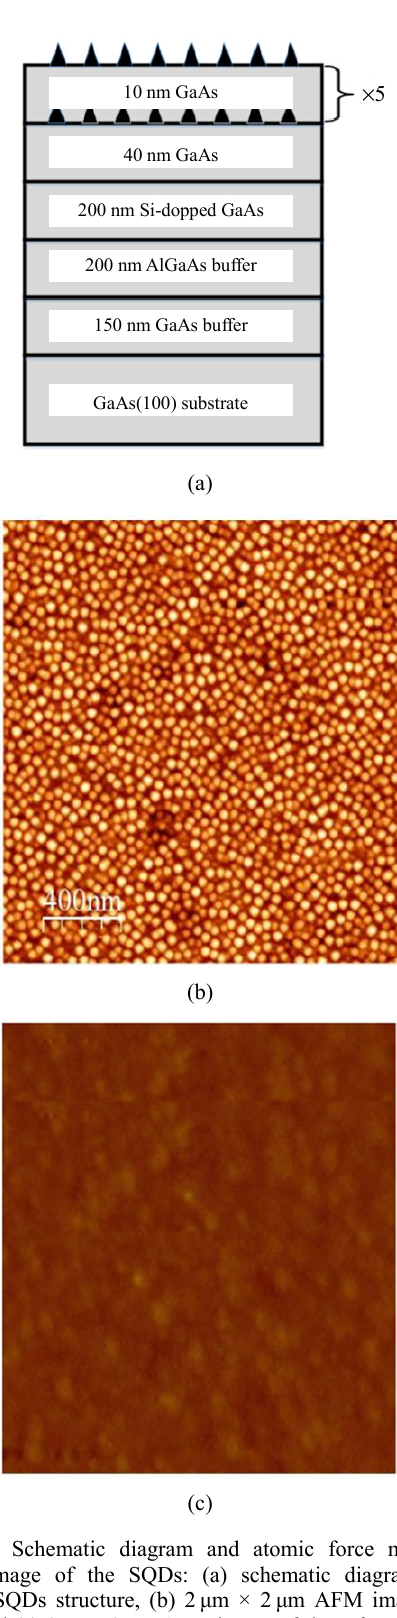
Fig. 1 Schematic diagram and atomic force microscope (AFM) image of the SQDs: (a) schematic diagram of the stacking SQDs structure, (b) 2 μ m × 2 μ m AFM image of the SQDs, and (c) 2 μ m ×2 μ m AFM image of the reference sample